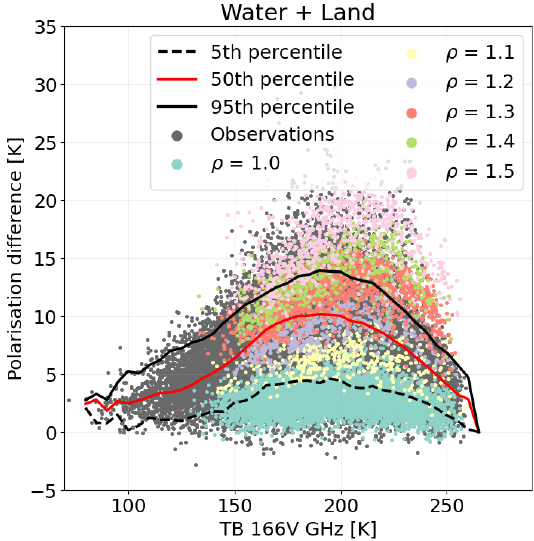
Figure A1. The polarisation differences (166V − 166H) as a function of brightness temperatures at 166V GHz (PD-TB V relationship) over water and land. The GMI observations are shown in dark grey, while the other colours represent the simulations for the different values of ρ . The three overlaid lines represent the 5th, 50th and 95th percentiles of the observed polarisation differences for each TB interval. The simulations were based on the Evans snow aggregate. The data affected by the surface were filtered out (see text). The simulations were from January 2009 and the observations were from January